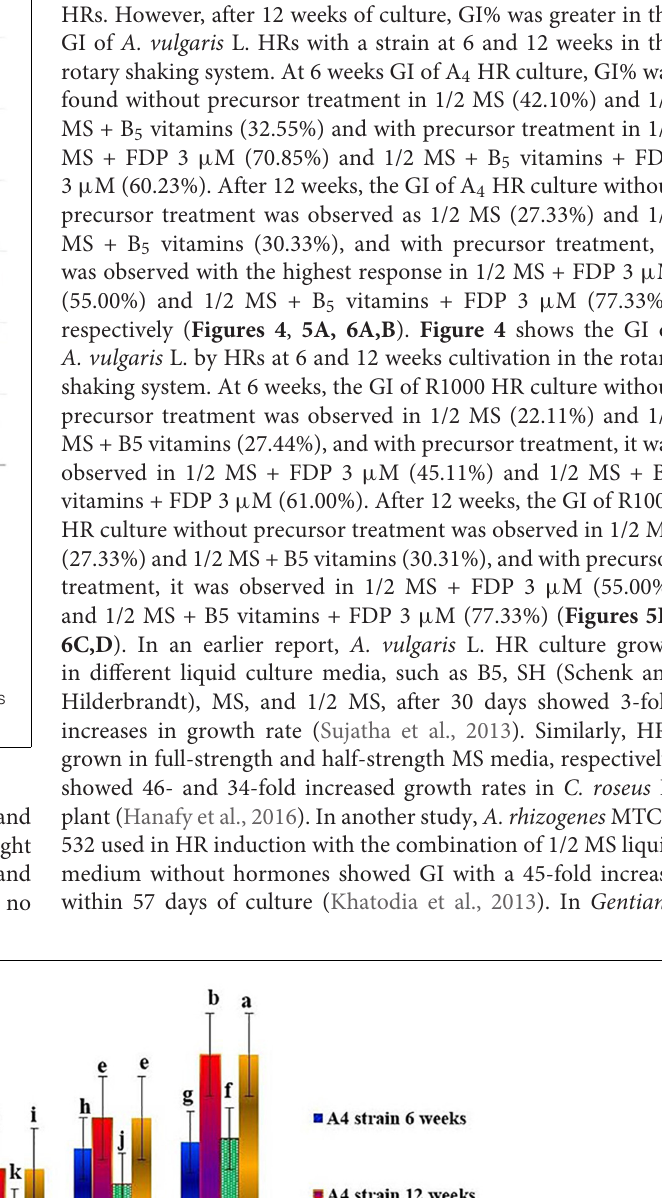
Frontiers in Plant Science |